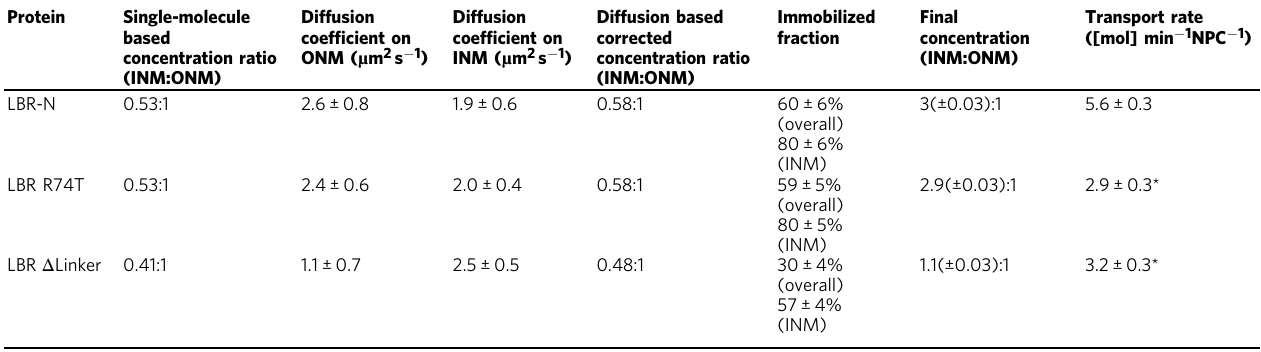
Table 1 Determined translocation rates for LBR and its mutants. Protein Single-molecule based concentration ratio (INM:ONM)